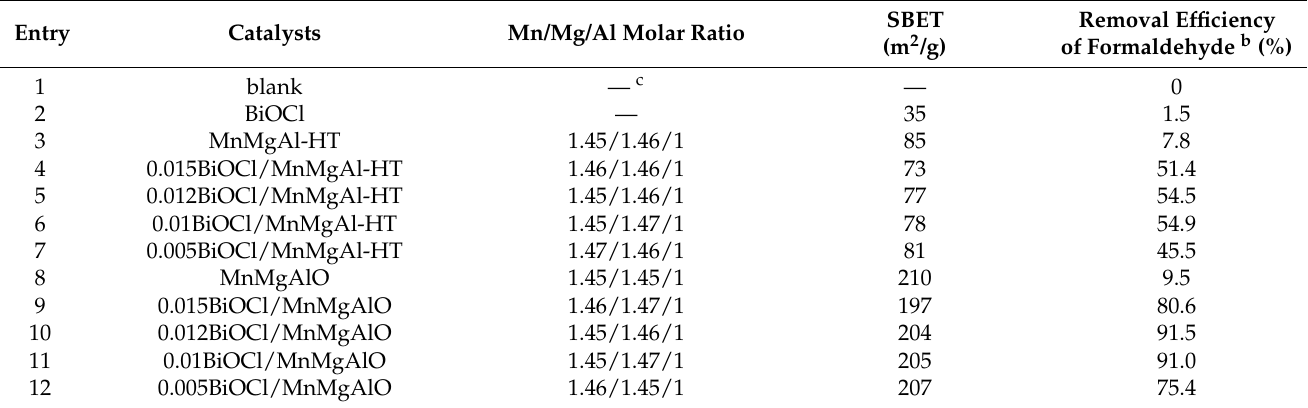
Table 1. Catalytic performance of samples in the removal reaction of formaldehyde a .